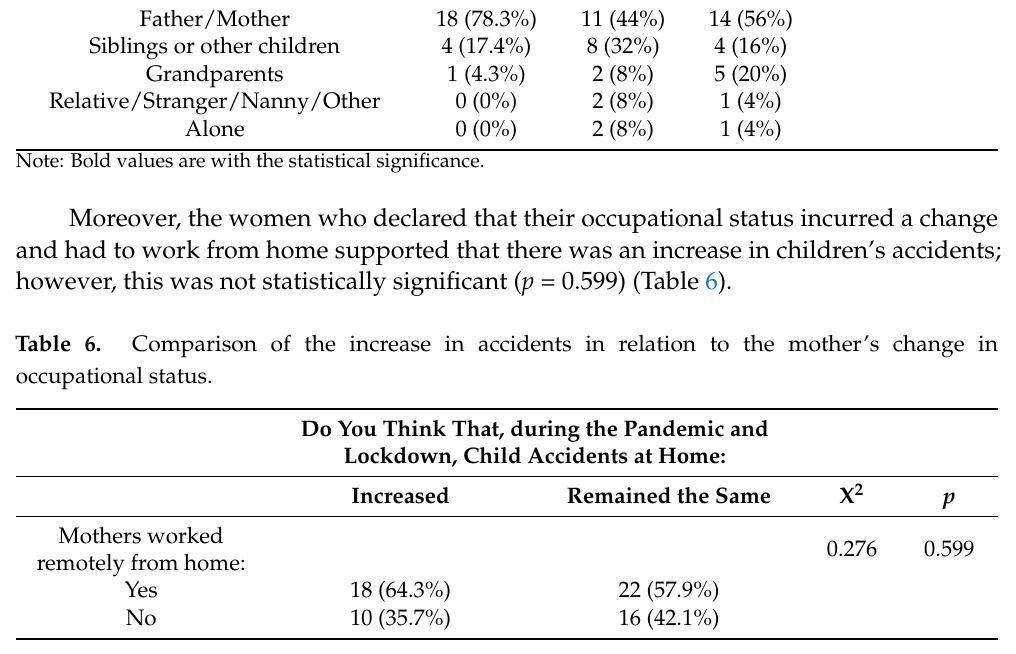
When the accidents occurred, the